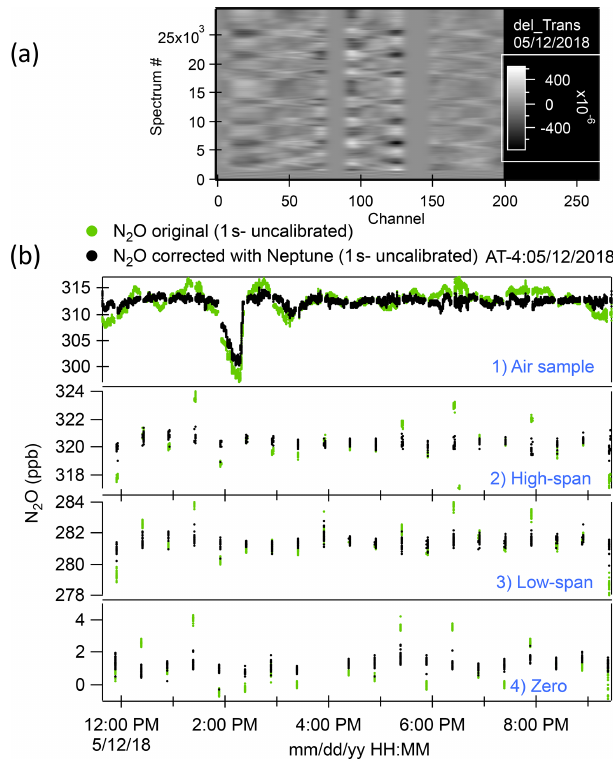
Figure 1. (a) A processed spectral array from the ATom-4 flight on 12 May 2018. “Channel” represents a point number in the spectra. Spectra have been grouped by type (i.e., calibration or ambient), with averages subtracted, absorption lines zeroed out (near chan- nels 75, 140, and 225). This residual spectral array is then smoothed with a binomial filter where the filter width corresponds to the linewidth of the original spectra. Shifts in fringe phases during al- titude changes are apparent. (b) Time series of ambient air samples and high-span, low-span, and zero calibrations for the same flight as (a) . Green dots are the original N 2 O data record. Black dots are the N 2 O data corrected with Neptune (no calibration applied at this